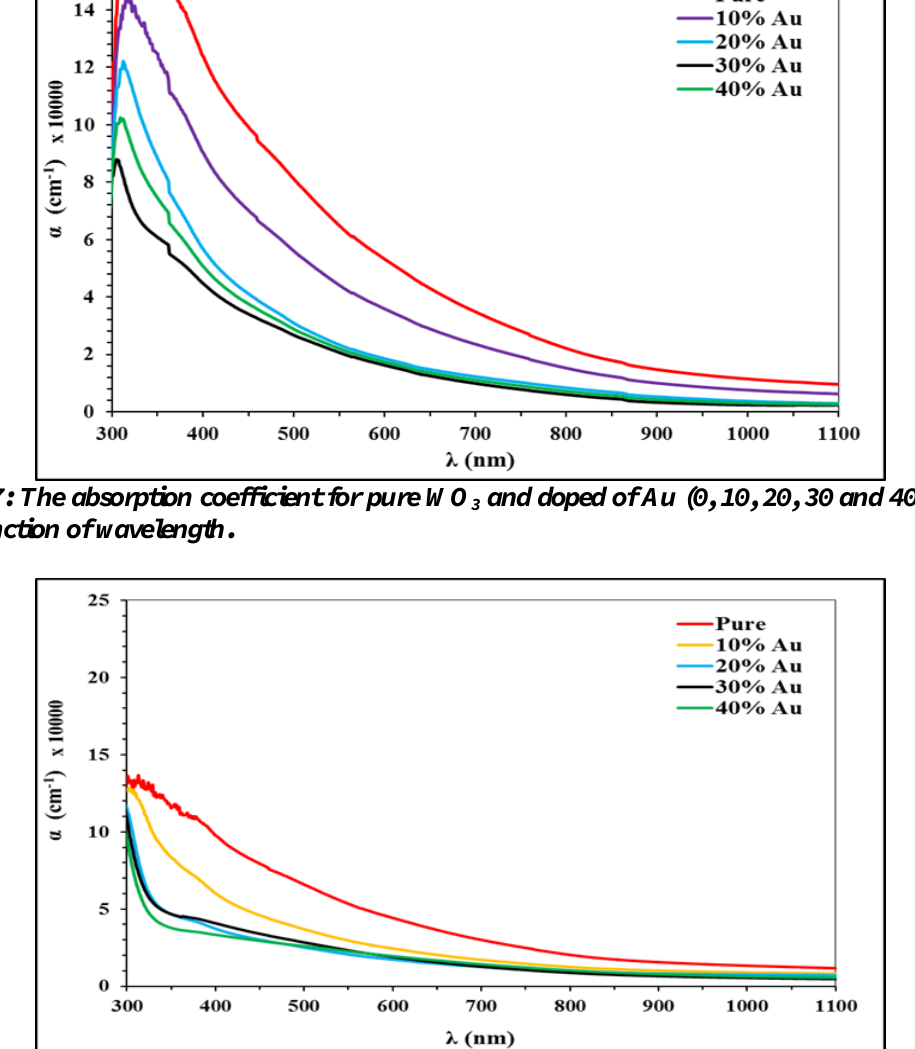
and doped of Au (0, 10, 20, 30 and 40)% as 3 =400 a